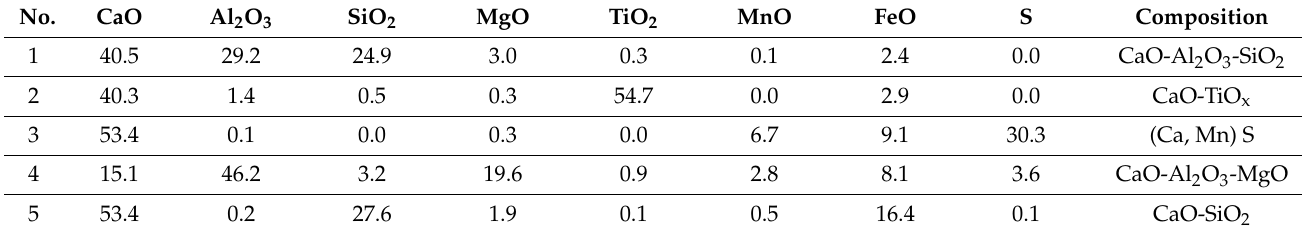
Table 5. The chemical composition of each part of the large-sized multiphase inclusion.